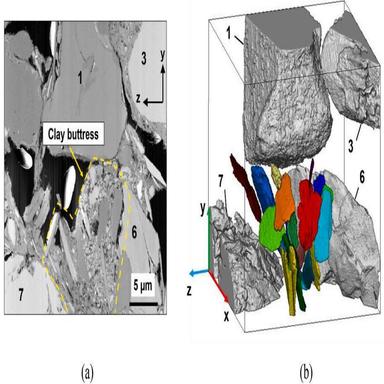
Clay buttress. (a) Selected slice from the FIB-SEM images showing the cross-section of a clay buttress (marked by dash line). (b) 3D visualization of the particles embedded in the clay buttress.